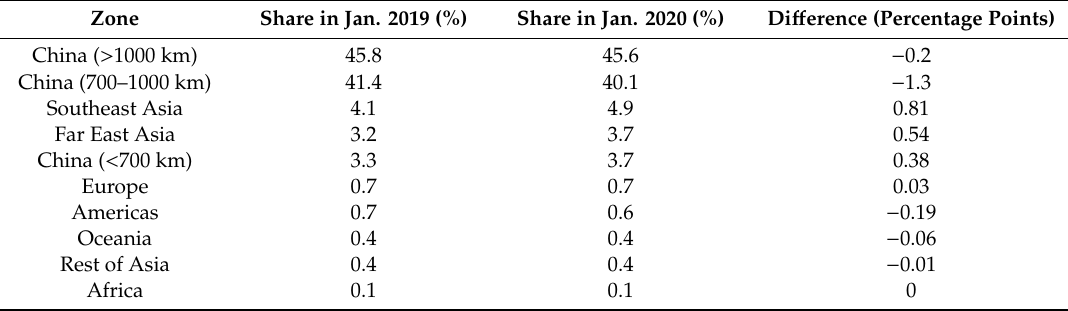
Figure 2. Estimated worldwide distribution of air transport passengers from Wuhan, January 2020. Table 1. Relative shares of aviation passengers from Hubei province to major zones, January 2019 data versus estimates for January 2020.